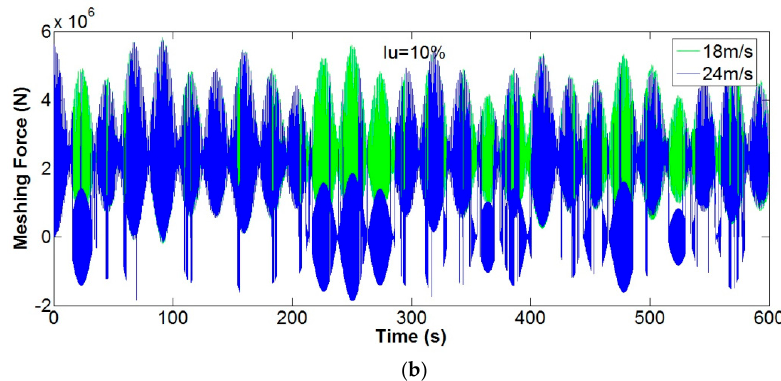
Figure 8. The meshing force between planetary gear and sun gear: ( a ) is for wind speed of 4 and 8 m/s; ( b ) is for wind speed of 18 and 24 m/s.